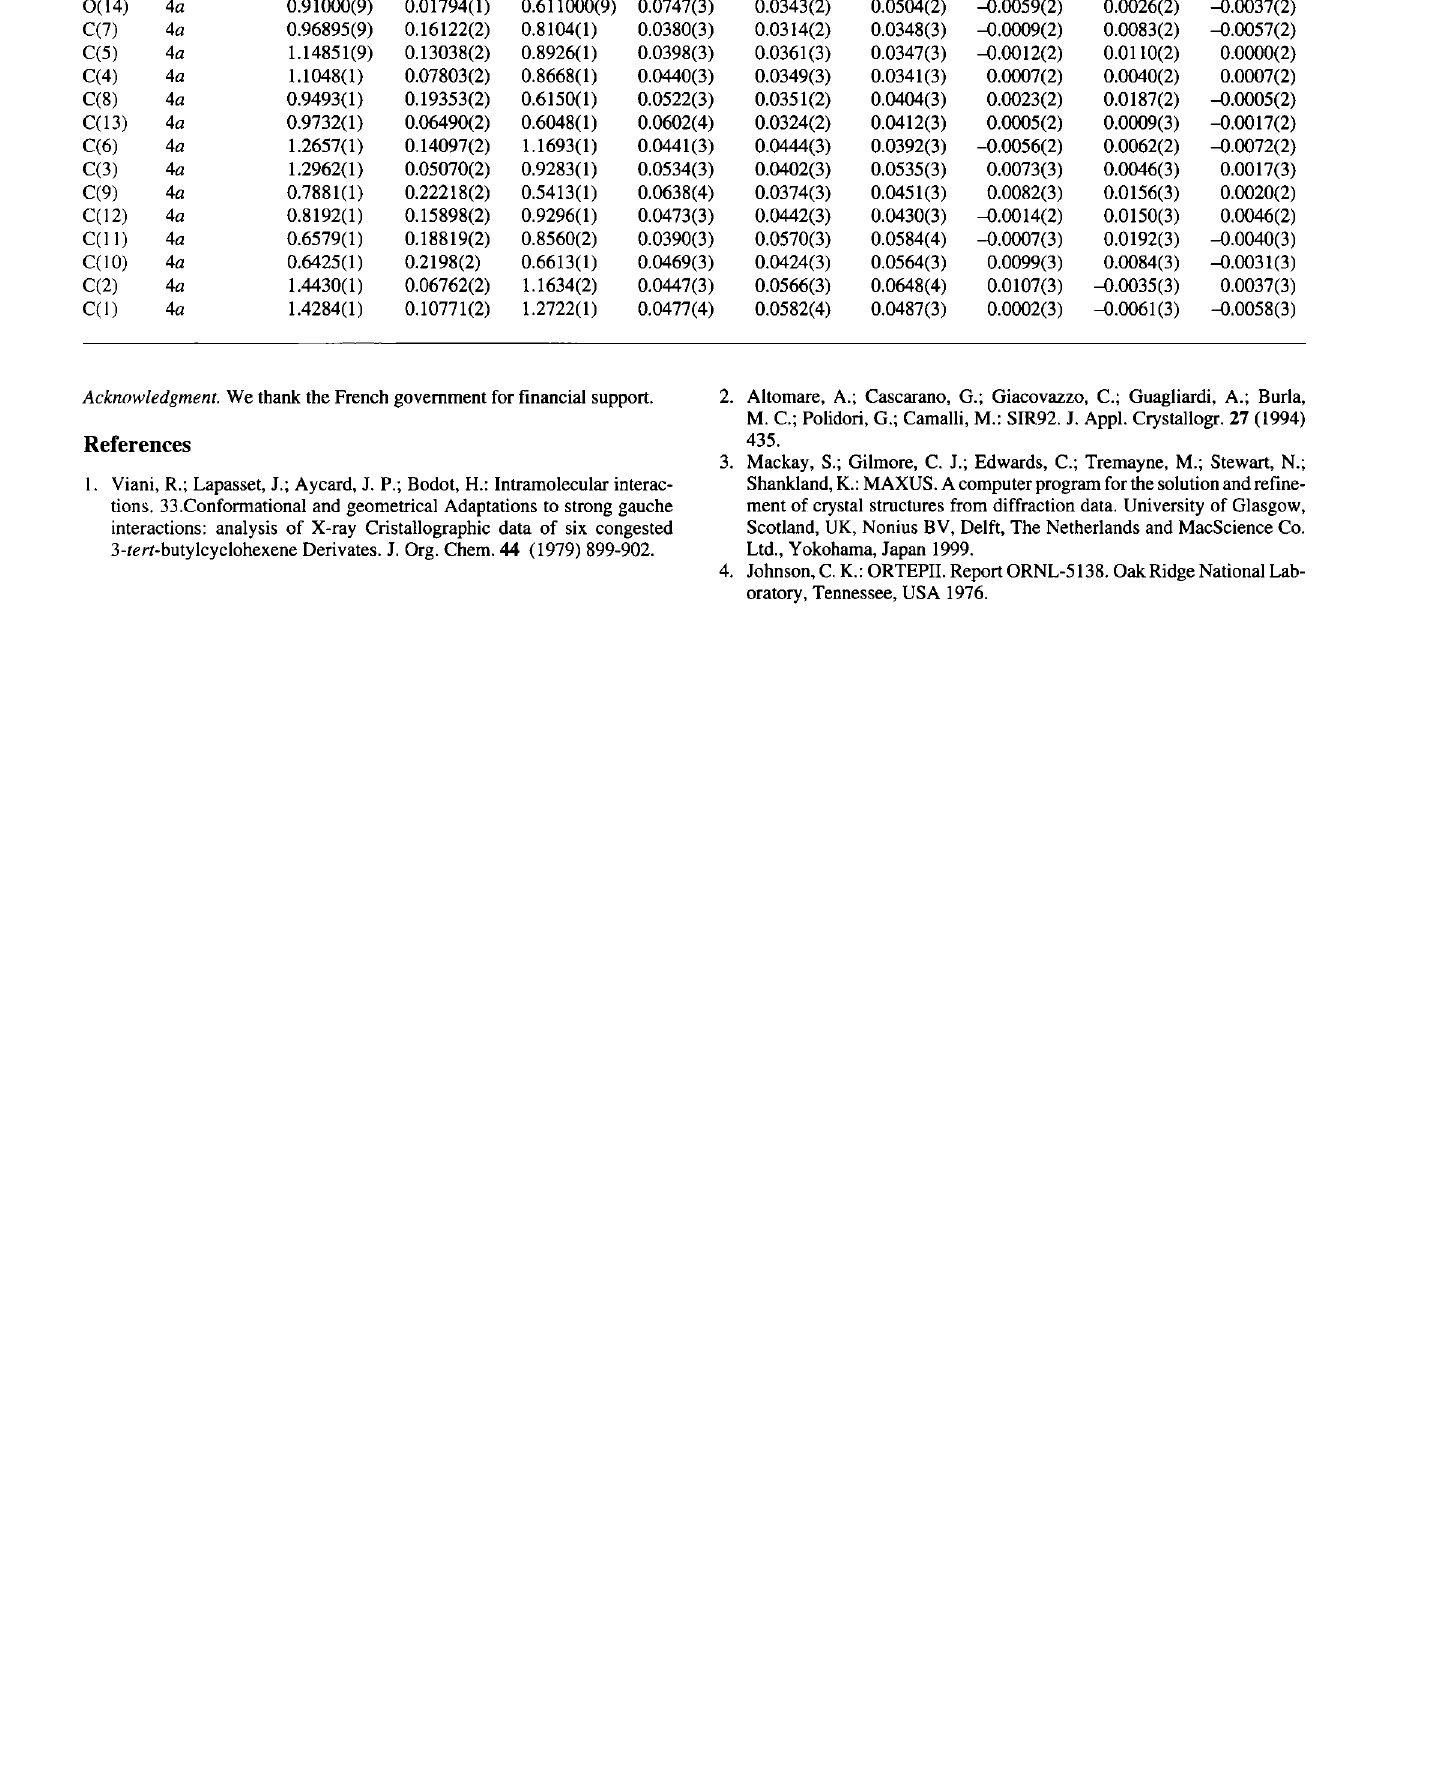
Table 3. Atomic coordinates and displacement parameters (in Â 2